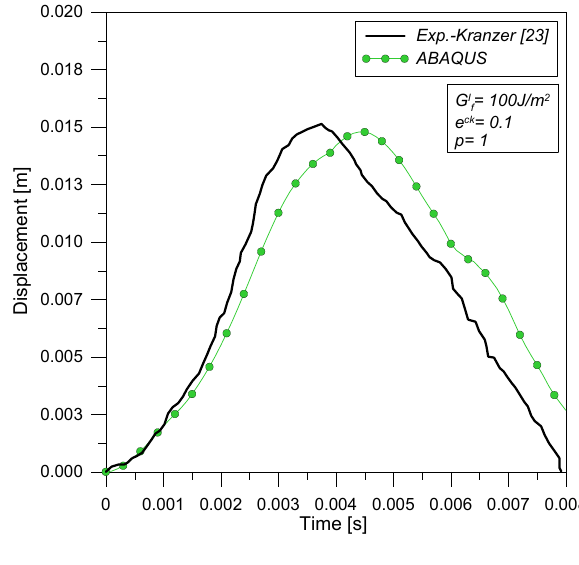
Figure 7. Deflection at the center of panel, as a function of time. Experimental (Kranzer, [23]) and numerical (ABAQUS) results.